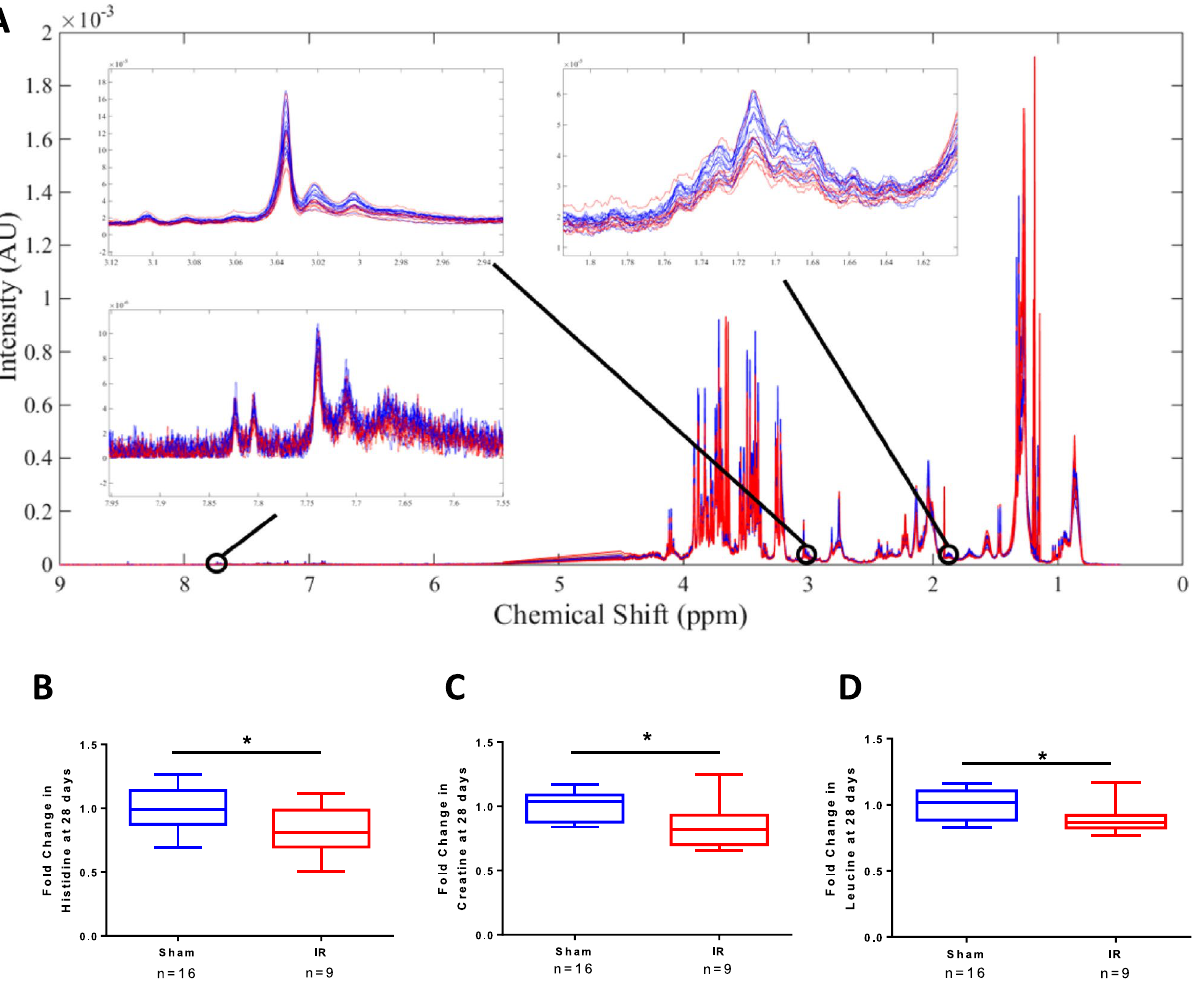
Figure 9. (A) 1 H CPMG NMR spectra coloured by operation type (blue: sham-operated, red: IR) from samples collected from vehicle/sham operated versus vehicle/IR animals at 4 weeks post IR surgery. The insets show the significant reductions in the resonance from histidine, creatine, and leucine (left to right respectively) after IR surgery. (B) Fold changes in histidine (left), creatine (middle), and leucine (right) between rats subject to sham- operations or IR injury, at 4 weeks post-surgery. Two-tailed Student’s t-test shows a significant difference in